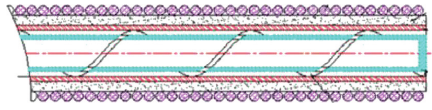
Figure 2: High-temperature heating pipe.